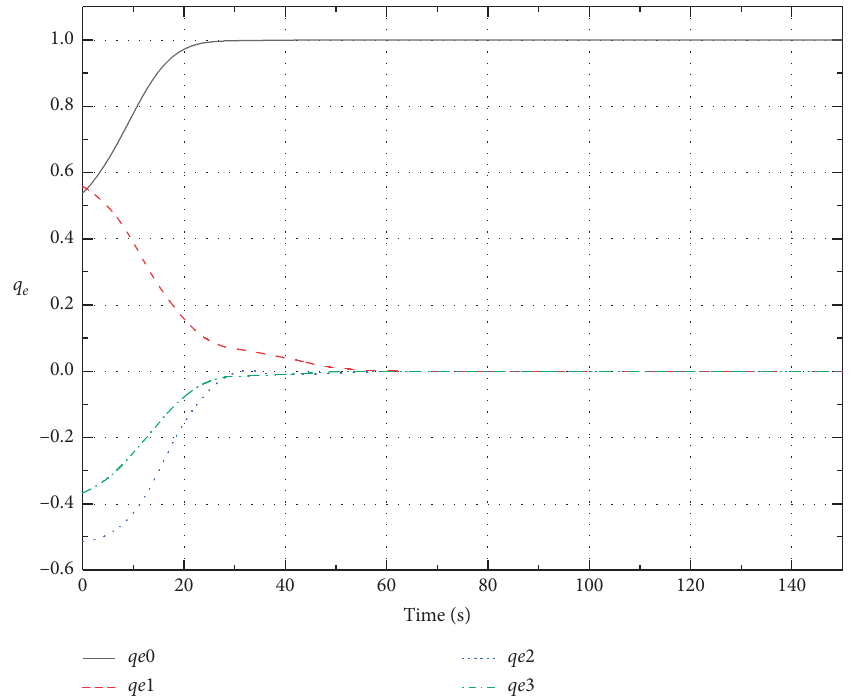
Figure 2: Trajectories of the vector component of the platform error quaternion.